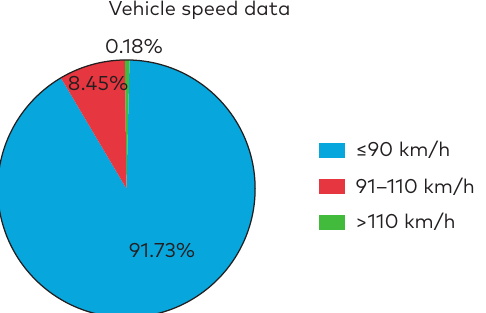
Figure 4. Speed data recorded by the average speed enforcement systems in the period from December 2018 to February